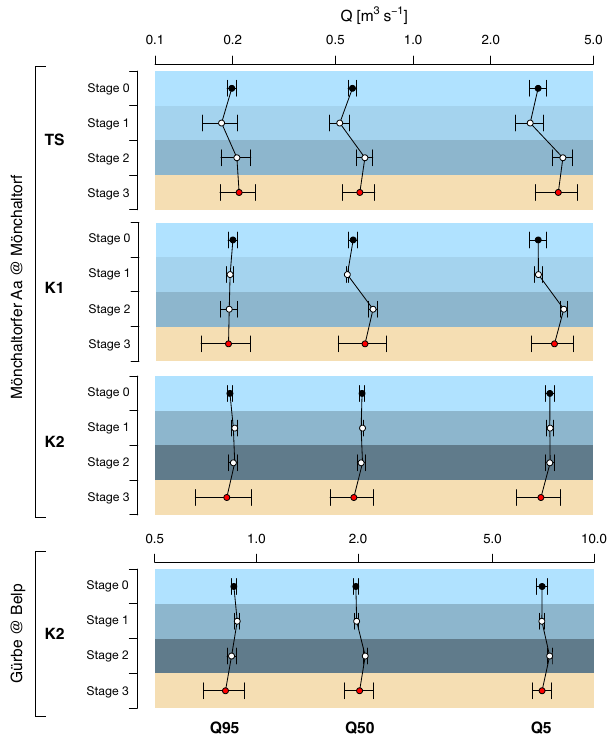
Figure 6. Absolute changes in flow quantiles during different work- flow